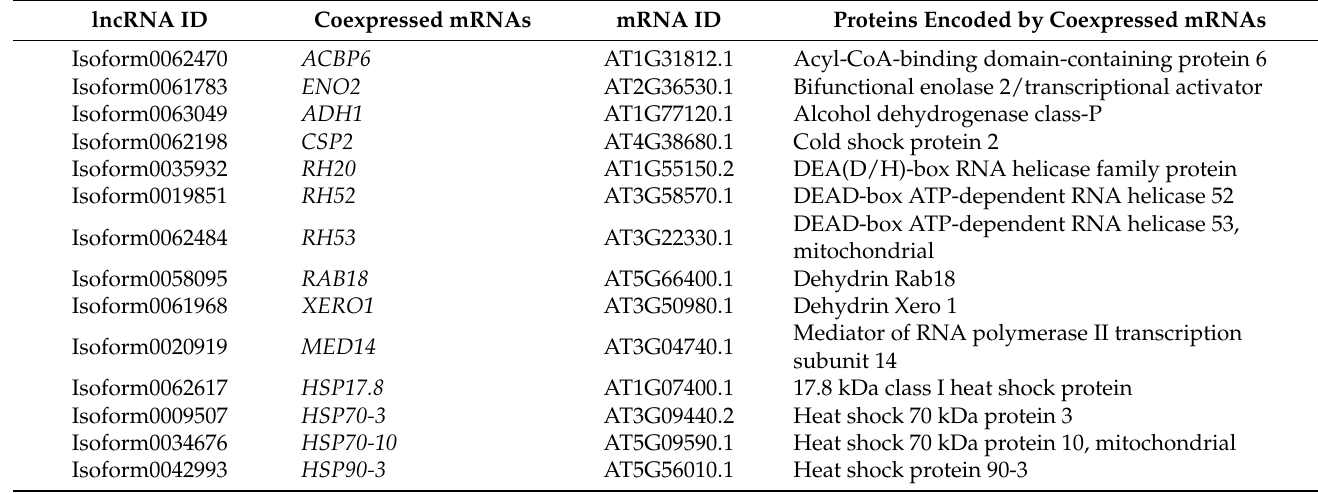
Table 4. Fourteen lncRNAs directly linked with temperature response.